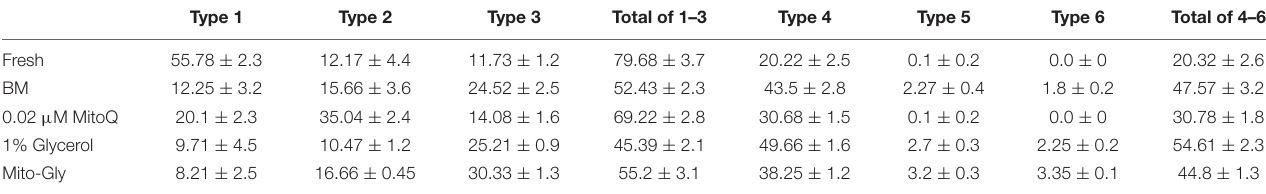
TABLE 1 | Percentage (mean ± SE) of fresh and vitrified spermatozoa with different types of ultrastructural changes in the spermatozoa membrane and acrosome.